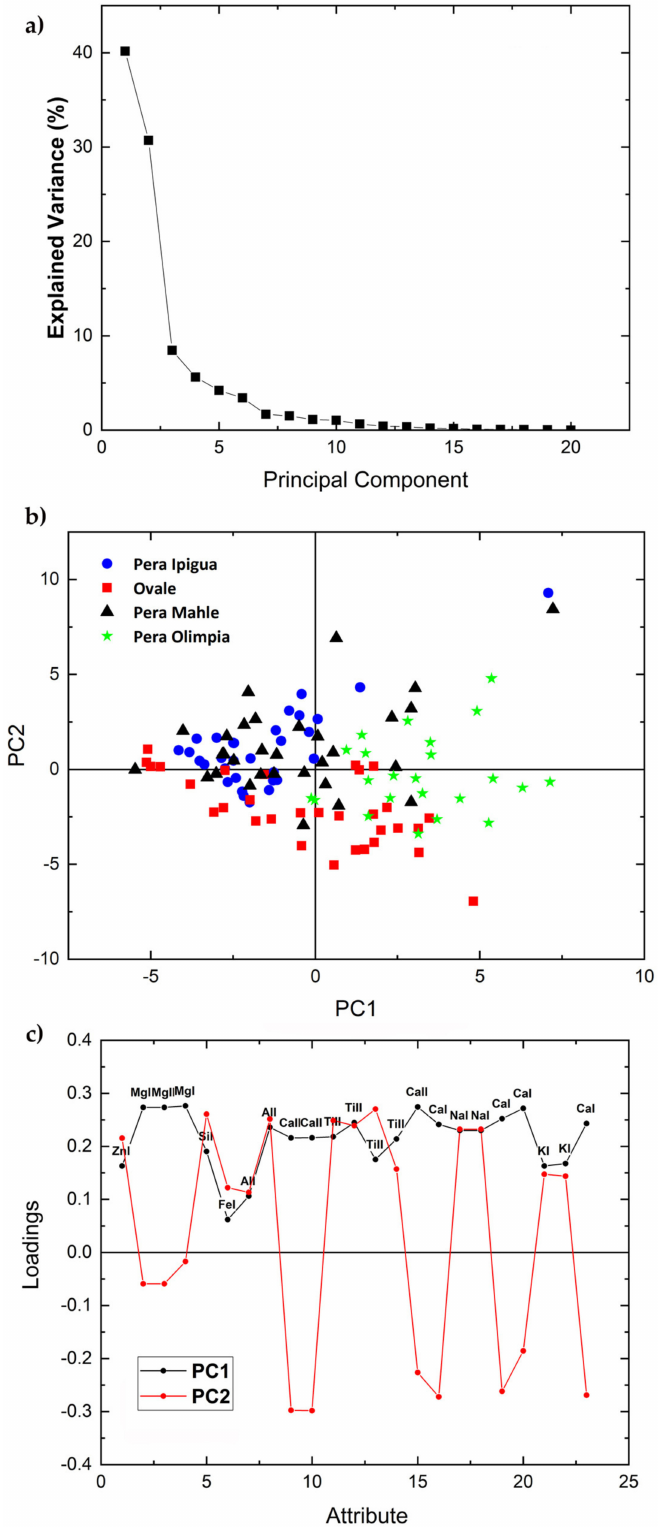
Figure 2. Scree plot ( a ), PCA 2-dimensional score plot of PC2 versus PC1 ( b ), and loading plot showing how each variable correlates to each PC ( c ) of the four accessions of the Common variety of set